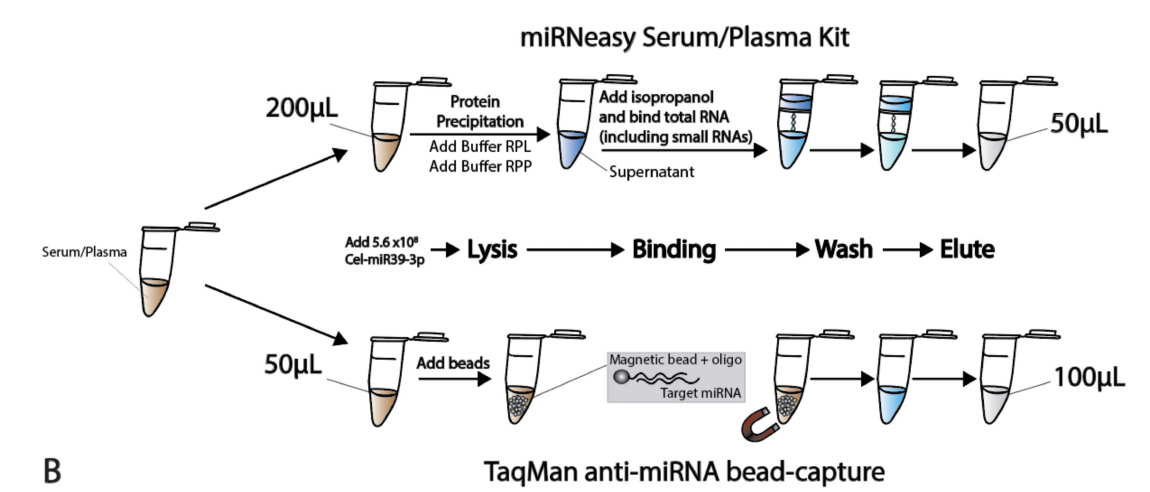
Figure 1. Schematic overview of the study set-up and workflow. ( A ) A schematic overview of the study setup used, depicting the acquiring of the samples, isolation, quality control and quantification techniques used. ( B ) Schematic overview of the workflow used with the two isolation protocols (Qiagen kit and bead-capture).